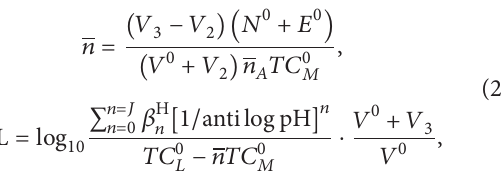
complexes of ligand (L 2